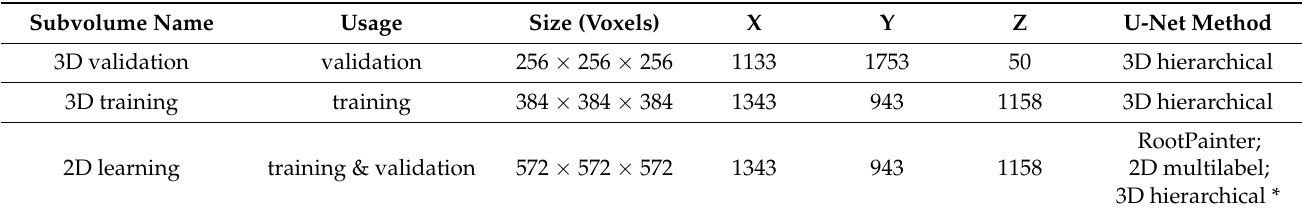
Table 2. U-Net training and validation subvolume details (shown in Figure